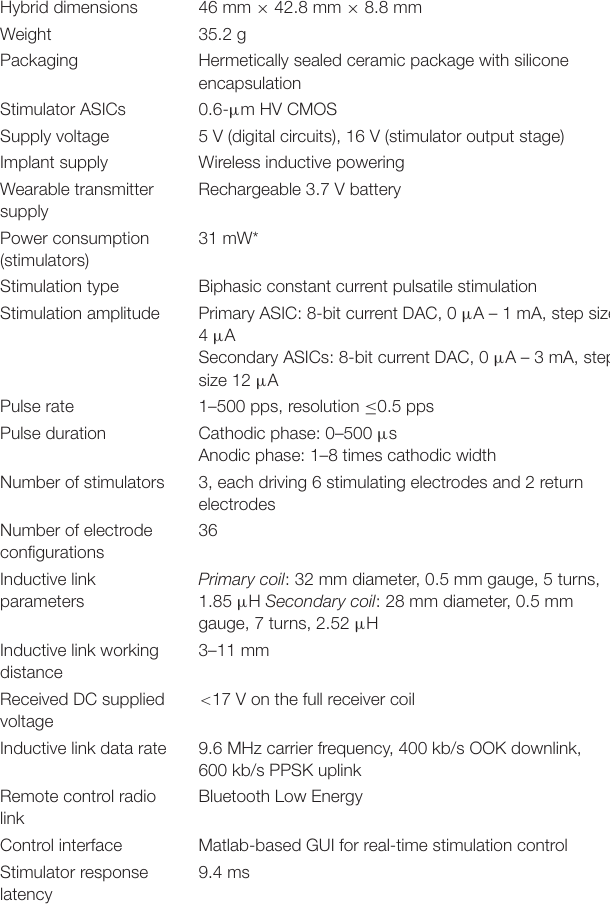
TABLE 1 | Features and performance of the implant